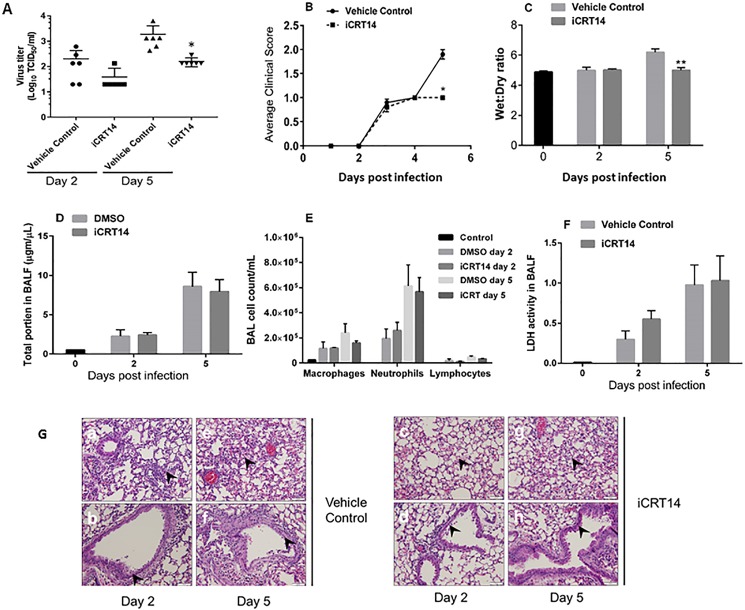
Effect of iCRT14 on lung injury and inflammation of mice challenged with a sublethal dose of influenza virus A/PR/8/34.C57BL/6J mice were infected with A/PR/8/34 (100 pfu/mouse). Mice euthanized on day 0 of the study were used as a control. Mice received either iCRT14 (50 mg/kg) or vehicle control daily beginning one day prior to infection until day 2 or day 5 after infection. (A) Virus titers in total lung homogenate (n = 6). (B) Average clinical scores; 0 = normal, 1 = ruffled fur, 2 = inactive, 3 = hunched back (n = 10–20). (C) Lung water content as measured by wet-to-dry ratio (n = 4). (D) Total protein in BAL fluid (n = 4). (E) LDH activity in BAL fluid (n = 4). (F) Inflammatory cells in BAL (n = 3–4). The data are presented as the mean ± SE. *p < 0.05 vs. vehicle control on the corresponding days, **p < 0.01 vs. vehicle control on the corresponding days. For (A) and (C), Two-way ANOVA, post hoc sidak was used and 0 time group was not included in analysis due to lack of equal groups. For (B), Student’s t-test was used duo to unequal animal numbers in different groups. (G) Representative H&E photomicrographs from 6 mice are shown. A, B = day 2 vehicle control mice; C, D = day 2 iCRT14 mice; E, F = day 5 vehicle control mice; G, H = day 5 iCRT14 mice. The dark arrowheads in Panels A, C, E, G represent alveolar histiocytic and neutrophil infiltrations with associated hemorrhage. The arrowheads in Panels B, D, F, H represent major airway degeneration/necrosis, histiocytic and neutrophil infiltration. Scale bar = 50 μm.